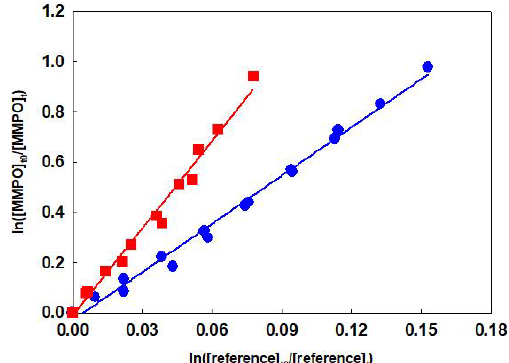
Figure 2. Relative-rate data for the reaction of OH radicals with (1 E )-1-methoxy-2-methyl-1-penten-3-one using propene ( ) and isobutene ( ) as reference compounds at 298K and the atmospheric pressure of